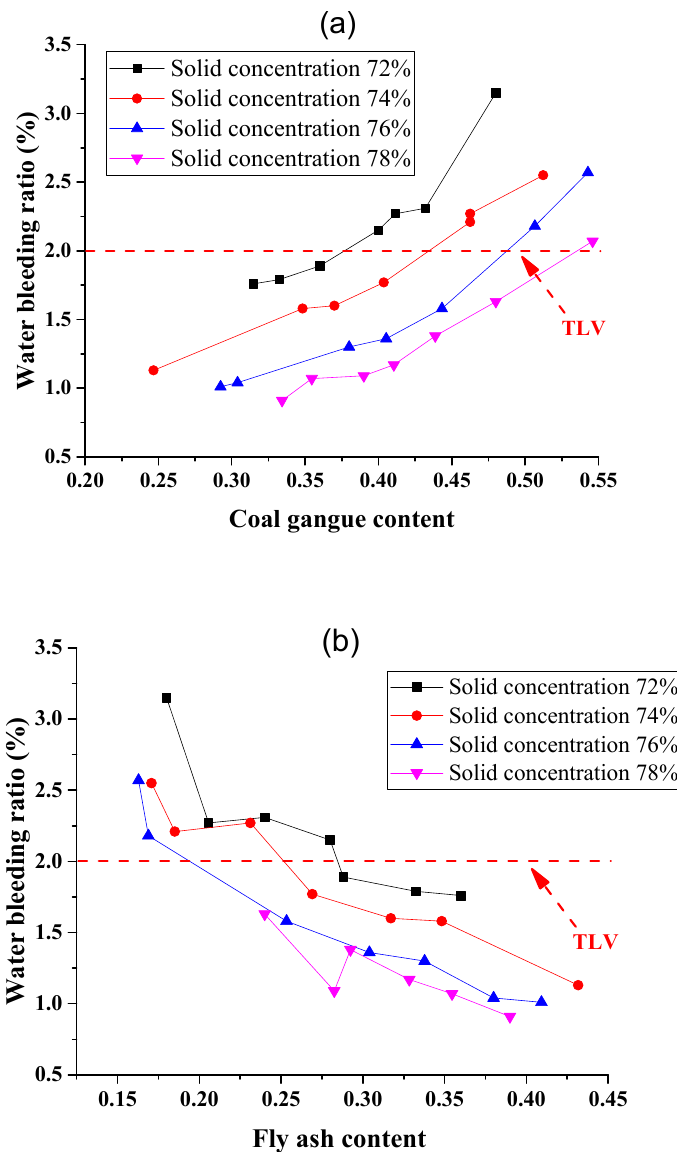
Figure 8. Effects of coal gangue and fly ash content on the water bleeding property of CPB slurry: ( a ) Coal gangue content effects; and ( b ) Fly ash content effects.